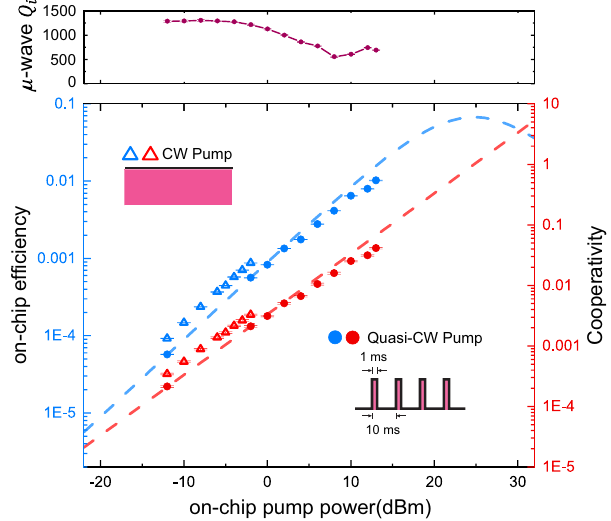
Fig. 4 Conversion ef fi ciency. On-chip conversion ef fi ciency (blue) and cooperativity (red) as a function of the peak optical pump power in the input waveguide. The discontinuity in the CW and quasi-CW pump data is due to switching to different pairs of optical modes during the measurements. The maximum conversion ef fi ciency is recorded with a peak pump power of 13.0 dBm. The dashed lines are the theoretical predictions obtained from the data measured with a quasi-CW pump. The measured intrinsic microwave Q under different optical pump powers are presented in the upper panel. The error bars show the standard derivations of the measurements. Table 1 Device